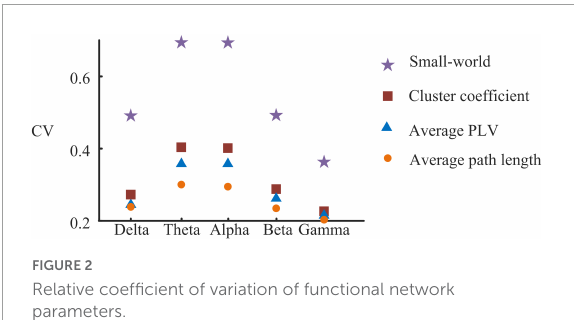
FIGURE2 Relative coefficient of variation of functional network